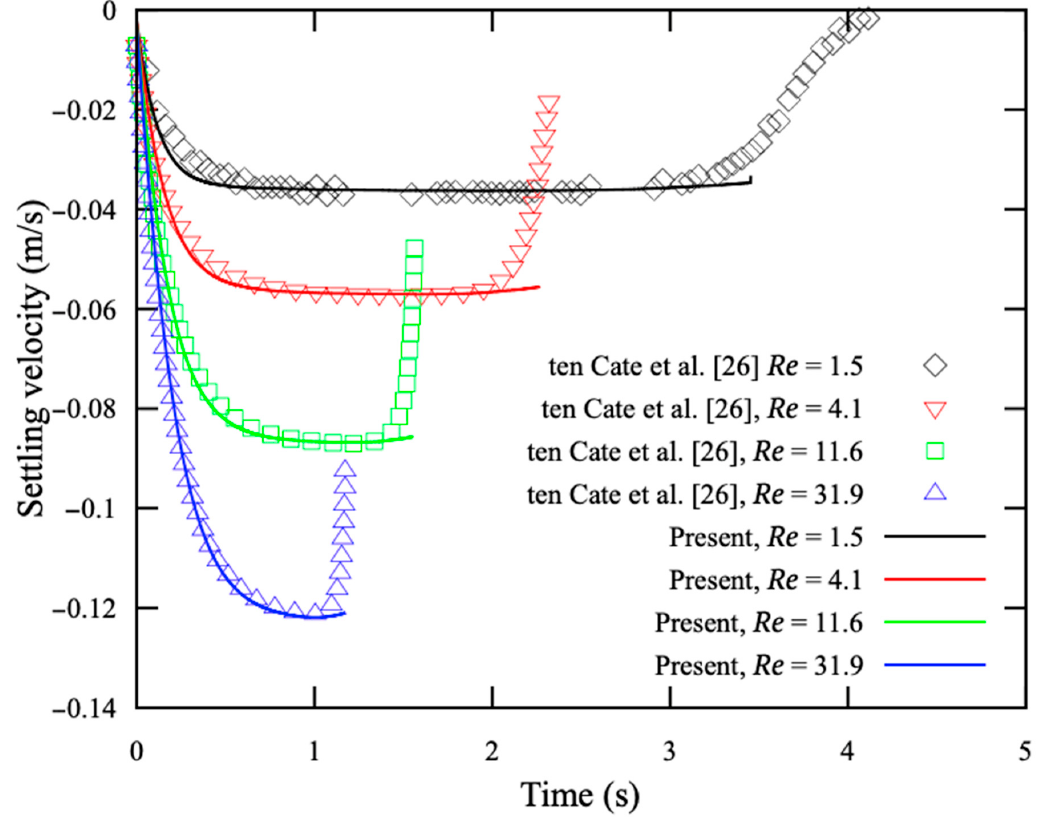
Figure 13. Settling velocity for di ff erent Reynolds numbers. Table 4. Velocity ratio ( u max / u ∞ ) for di ff erent Reynolds